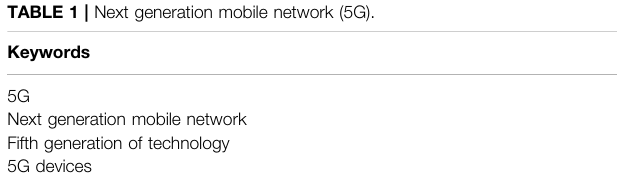
TABLE 1 | Next generation mobile network (5G).